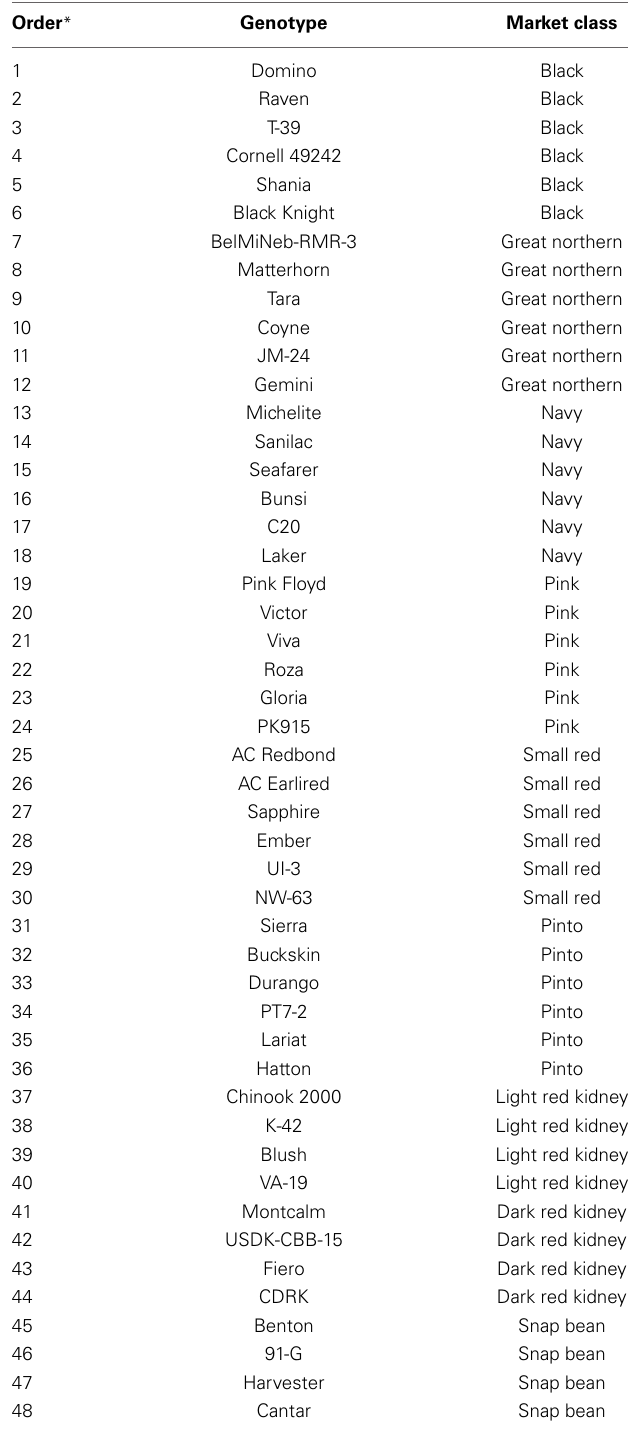
Table 2 | Genotypes used to test the performance of six markers in other market classes.